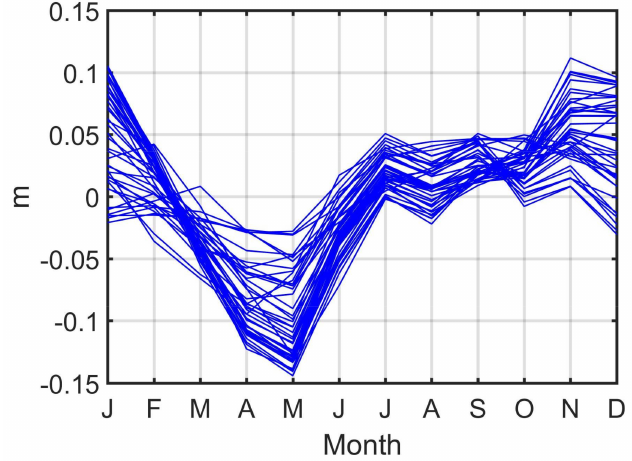
Figure 3. Mean sea level (m) calculated at the selected 42 stations over the time period 1993–2014 in the Baltic